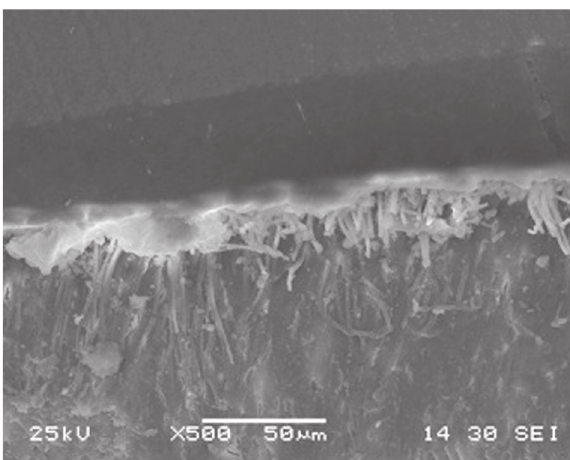
Figure 5- Photomicrograph of flat vestibular surface restored with P60/Adper Single Bond 2 restorative system